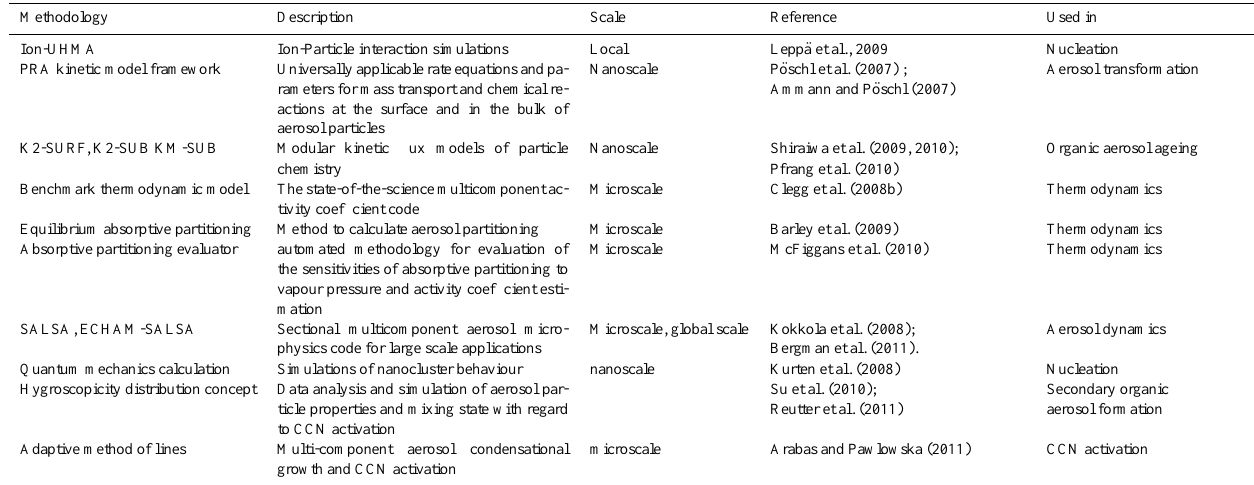
Table A4. Main computational methods used in EUCAARI (small scale).